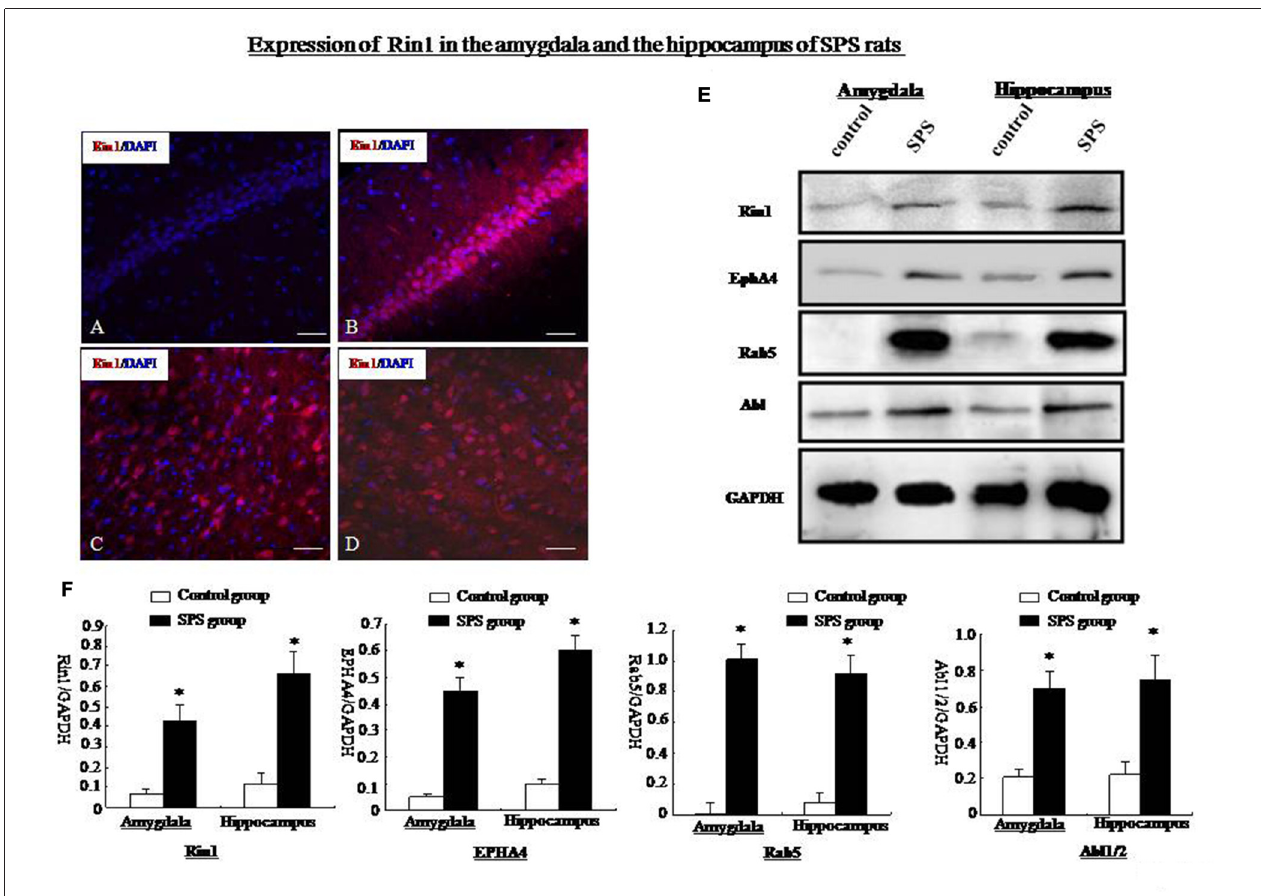
FIGURE 5 | (A) Rin1-ir in the hippocampus of the control group. (B) Rin1-ir in the hippocampus of the SPS group. (C) Rin1-ir in the amygdala of the SPS group. (D) Rin1-ir in the cingulate cortex of the SPS group. (E) Western blots showing expression of Rin1, EphA4, Rab5, and Abl in the amygdala and hippocampus of both groups. (F) Quantification of western blots showing higher expression of Rin1, EphA4, Rab5, and Abl in the amygdala and hippocampus of the SPS group compared with the control group ( ∗ P < 0.05 vs. the control group; Bar: 20 µ